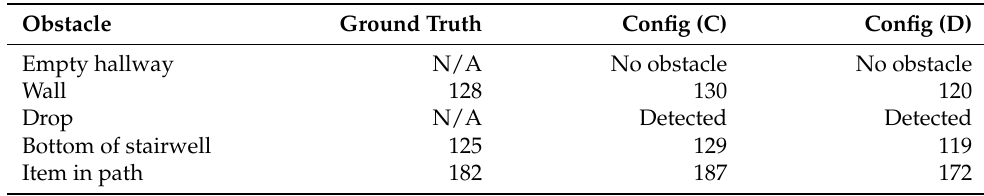
Table 2. Comparing the accuracy of configurations C and D for measuring the distance (cm) to several likely obstacle